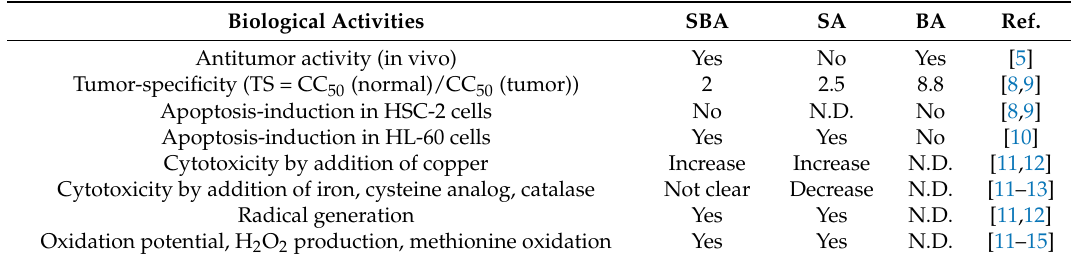
Table 1. Biological activities of SBA and its cleaved products, BA and SA.